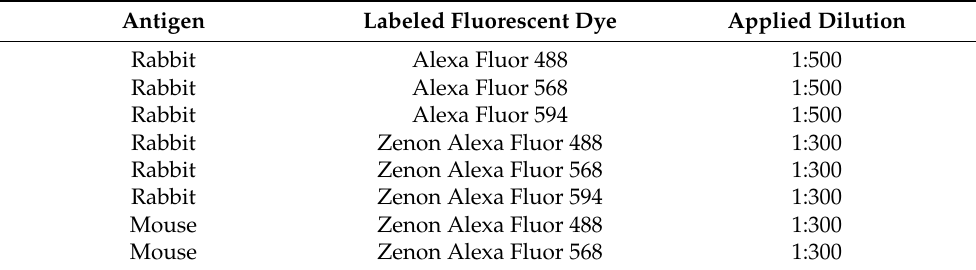
Table 2. The list of secondary antibodies used in this study. All from